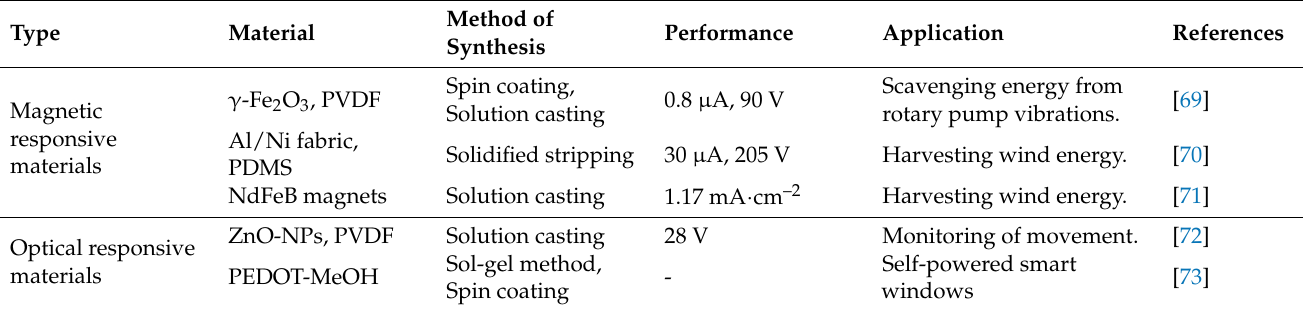
Table 1. Comparison of synthesis methods, properties and applications of TENGs combined with different types of smart